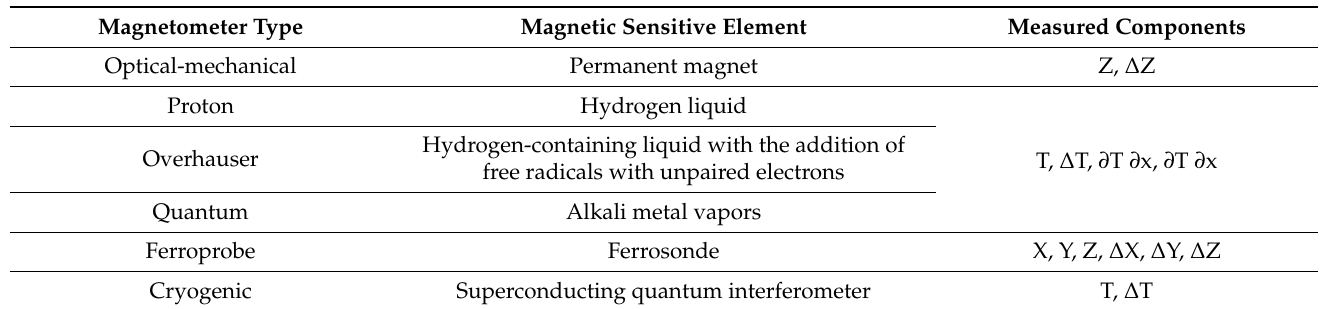
Table 1. Classification of magnetometers according to the principle of operation.